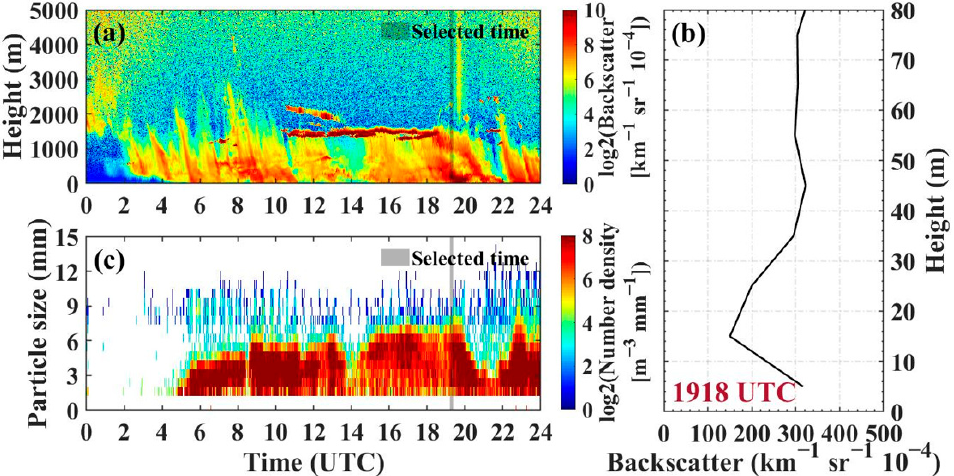
Figure 8. ( a , c ) represent the backscattered echo map of ceilometer and the average particle number density of parsivel 2 on 1 September 2016, respectively. ( b ) Backscatter profile of ceilometer at 1918